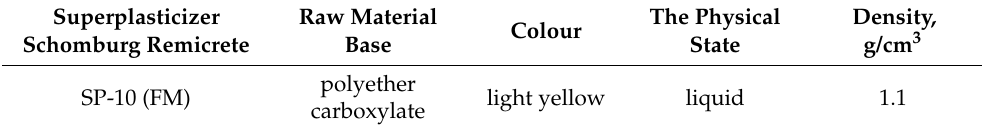
Table 6. Superplasticizer specifications.